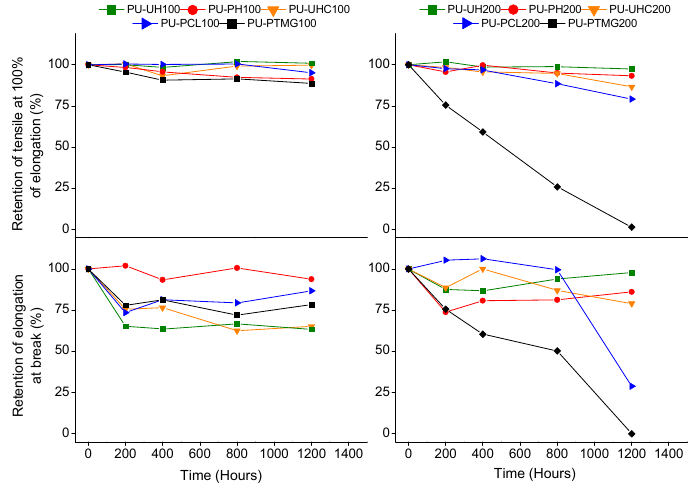
Figure 9. Durability test under weather resistance: ( a ) and ( b ), retention of tensile strength at 100% of elongation; ( c ) and ( d ), retention of elongation at break.